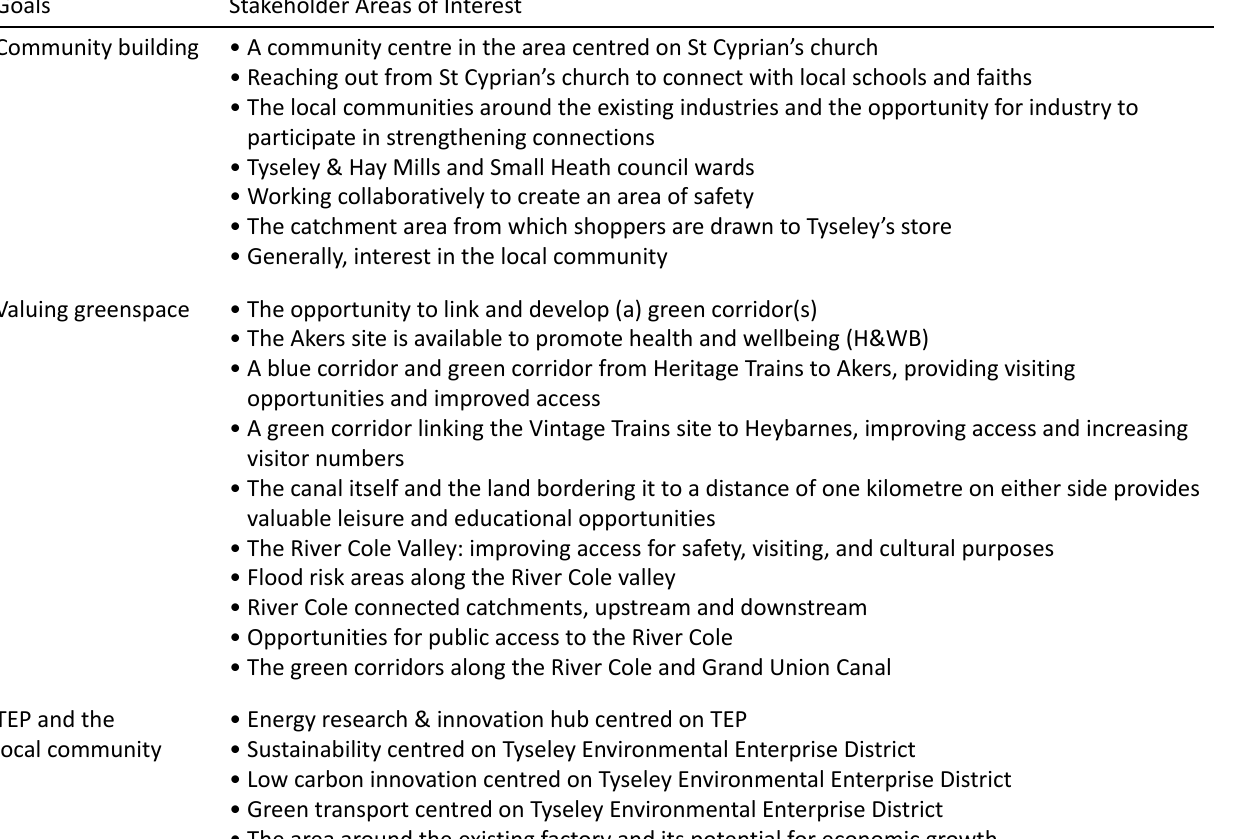
Table 3. Goals and stakeholder areas of interest in The Lost World. Goals Stakeholder Areas of Interest Community